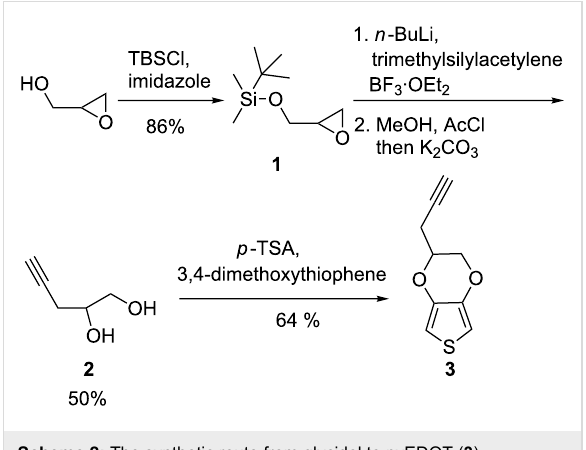
Scheme 2: The synthetic route from glycidol to pyEDOT ( 3